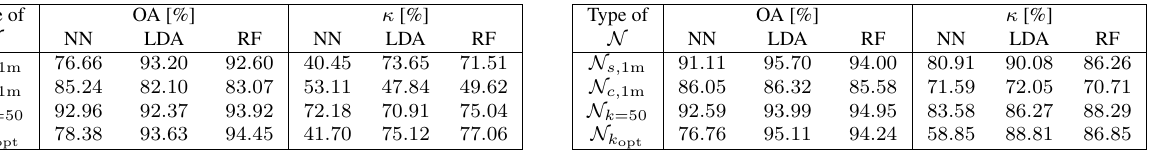
Table 4. Classification results obtained for Oakland-5C when us- ing the downsampled point cloud, four different neighborhood types and three different